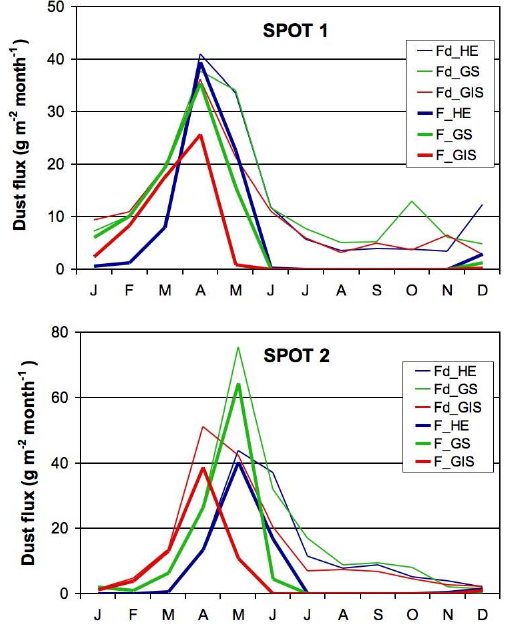
Fig. 10. Annual cycle of emitted dust flux averaged on each of the main deflation spots in the three simulated climate states, without ( F d ) and with vegetation effect ( F